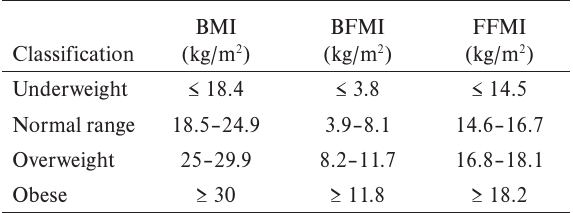
fied according to Kyle, Morabia, Schutz, and Pichard (2004); World Health Organization (2004)